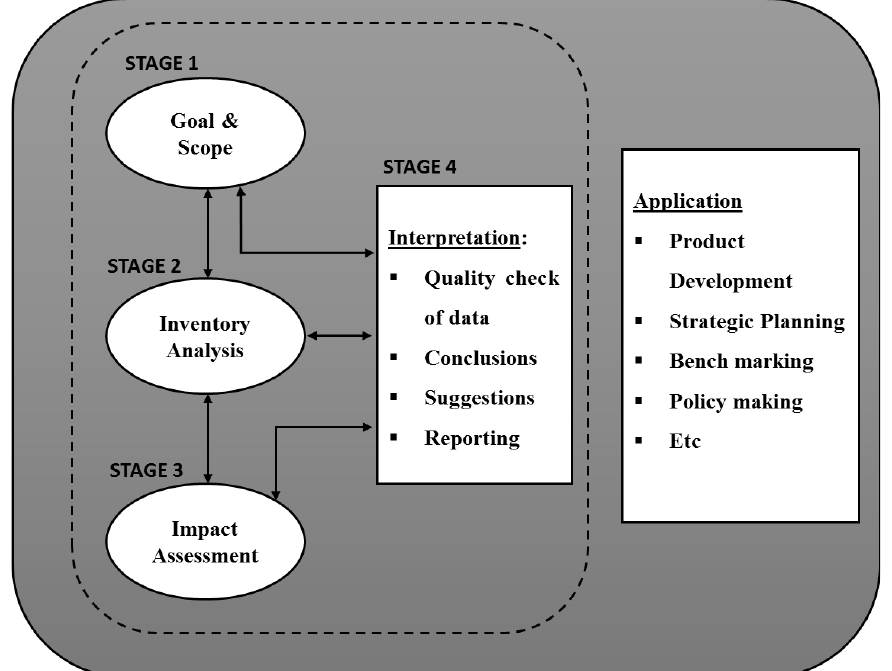
Figure 2. The stages of LCA analysis.